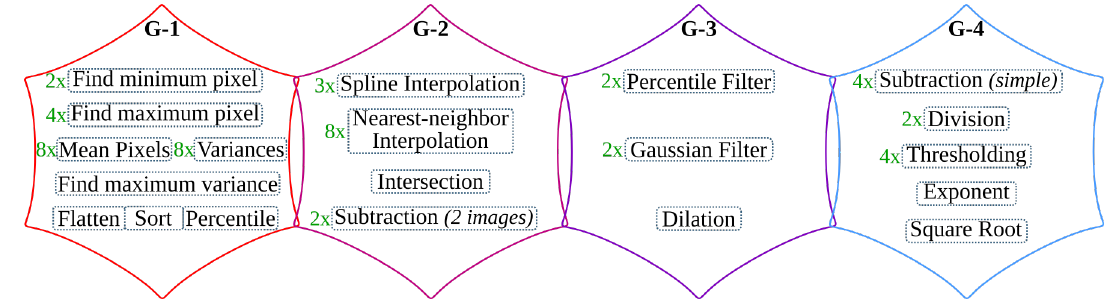
Figure 9. Operations involved in binarization processing pipeline grouped from G-1 to G-4